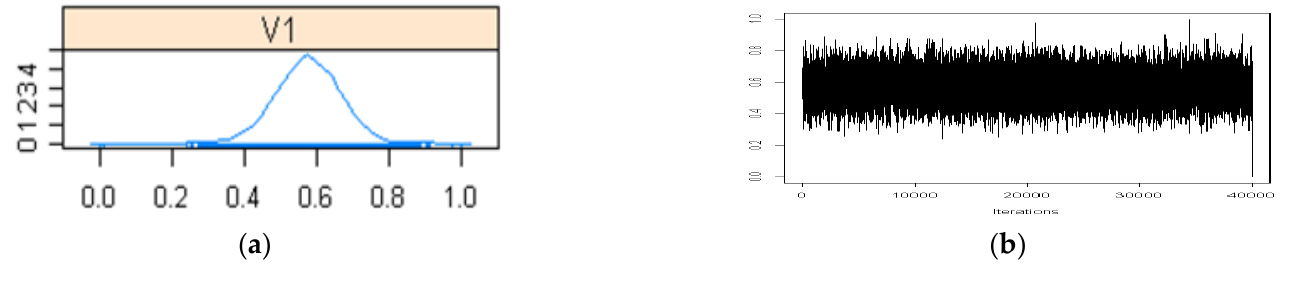
Figure 5. ( a ) Density plot of β 0 and ( b ) trace plot of β 0 (case study). Figure 6 shows that the density plot of τ 2 (panel a) is a right-skewed distribution. This potentially occurs since the conditional posterior distribution of τ 2 is the inverse gamma distribution. In addition, the trace plot of τ 2 (panel b) does not show good mixing. This suggests that the chains converged